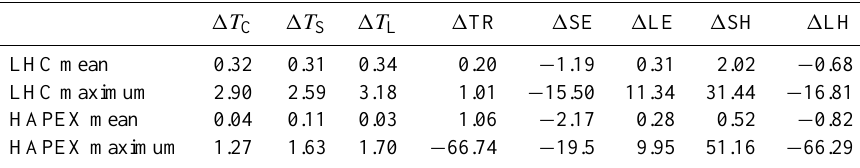
Table 4. Mean and maximum changes in daily temperatures and energy fluxes due to the stem–root flow (between optimal SLR run and control run) during the growing season. Canopy air temperature ( T C ) , soil surface temperature ( T S ) and leaf temperature ( T L ) are in ◦ C; transpiration (TR), soil evaporation (SE), leaf evaporation (LE), sensible heat (SH) and latent heat (LH) are in Wm − 2